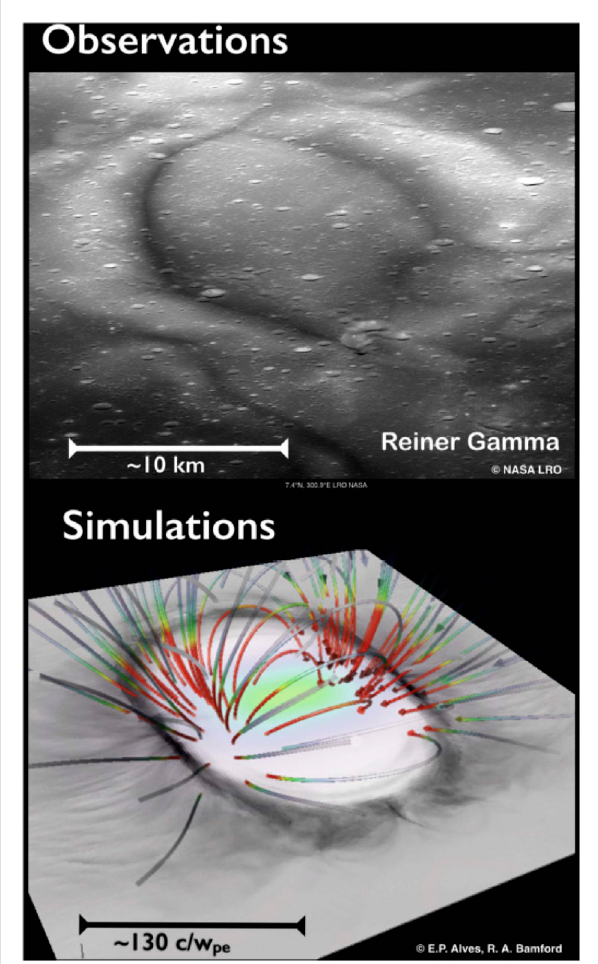
FIGURE 11 Top:ImageofthecentralregionoftheReinerGammaFormation lunar swirl, taken by Lunar Reconnaissance Orbiter. Bottom: A slice of the relative solar wind proton density above this lunar swirl obtained from a 3D simulation, with the initial magnetic fi eld lines corresponding to a single subsurface dipole. (From: Bamford et al.,